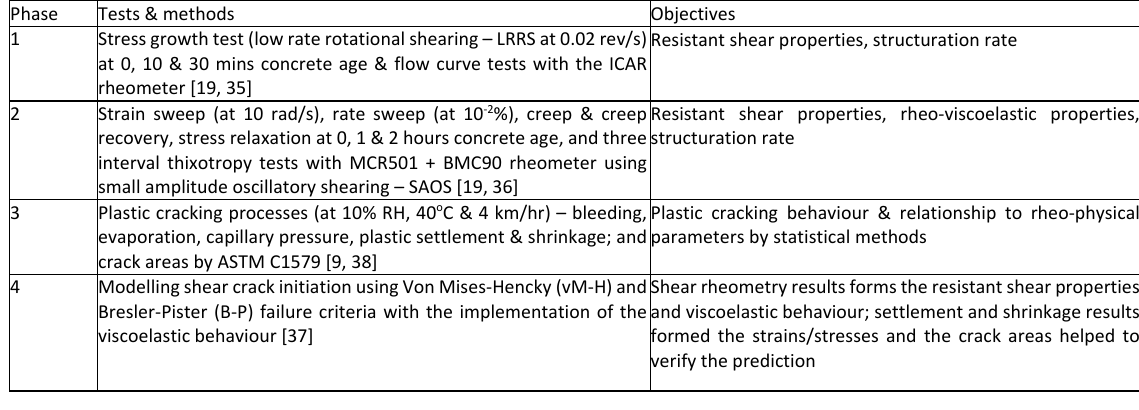
Table 2. Phases of the study, their objectives and test methods Phase